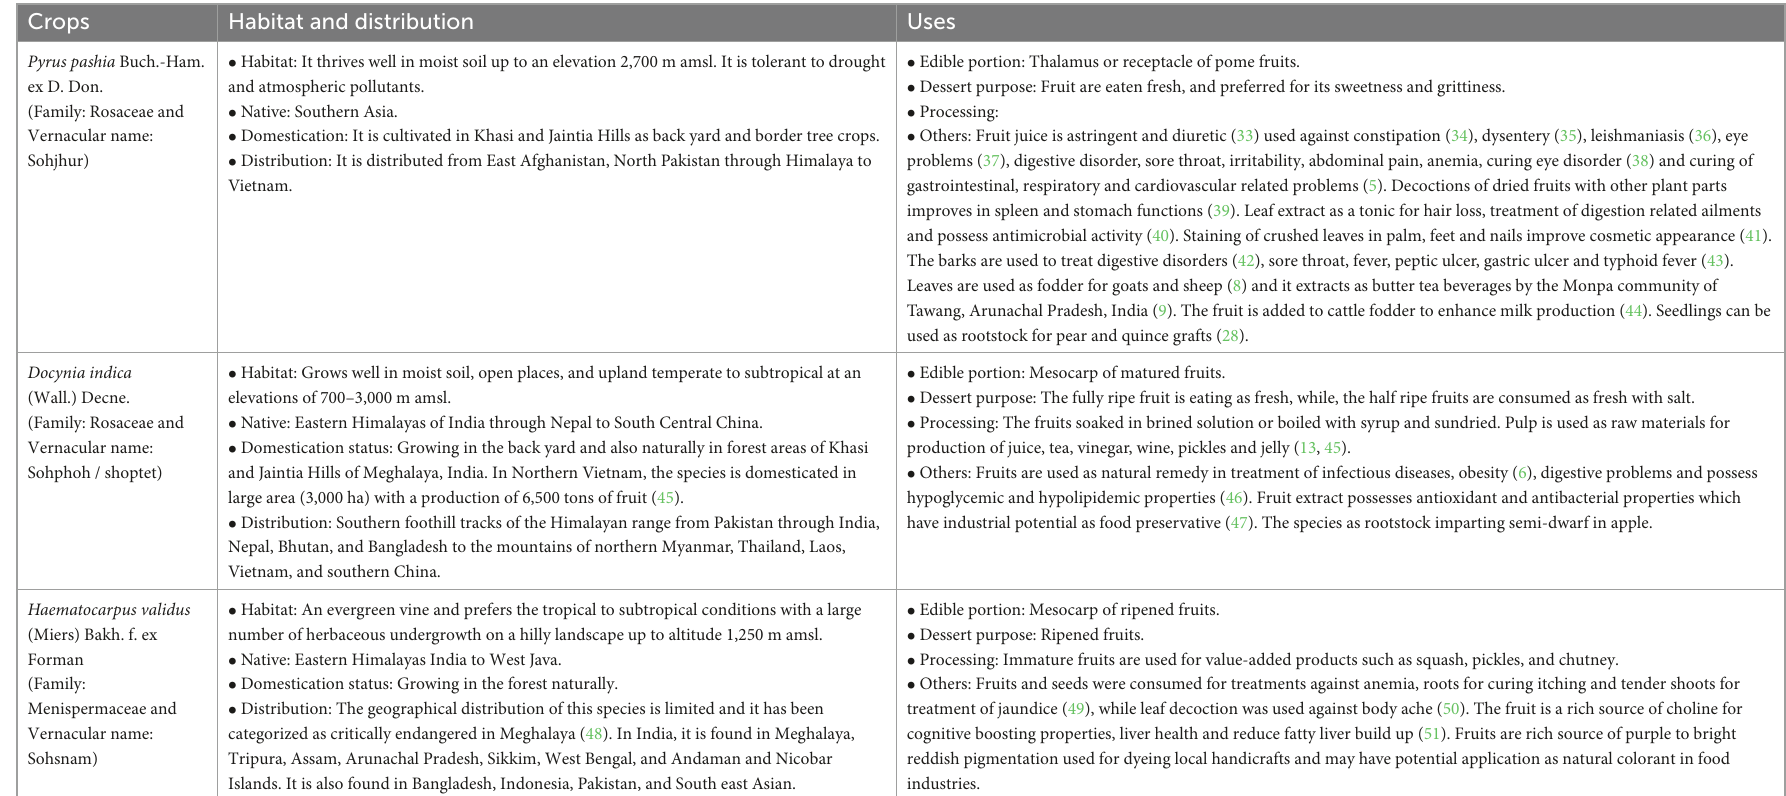
Crops Habitat and distribution